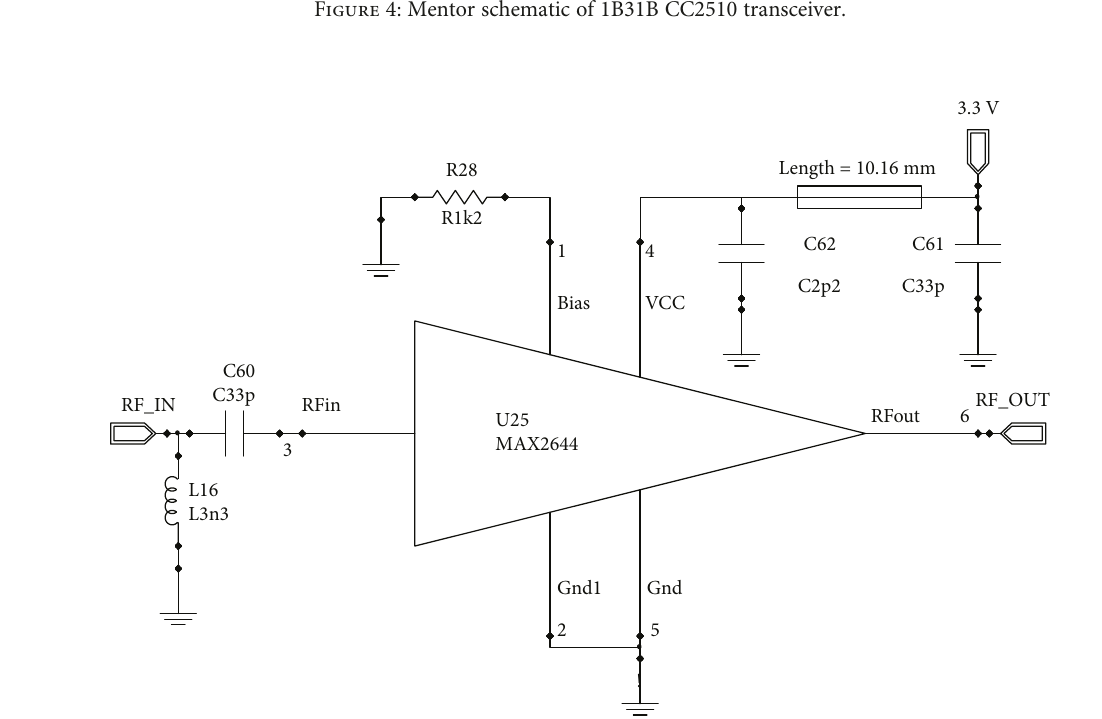
Figure 5: LNA schematic of RF front